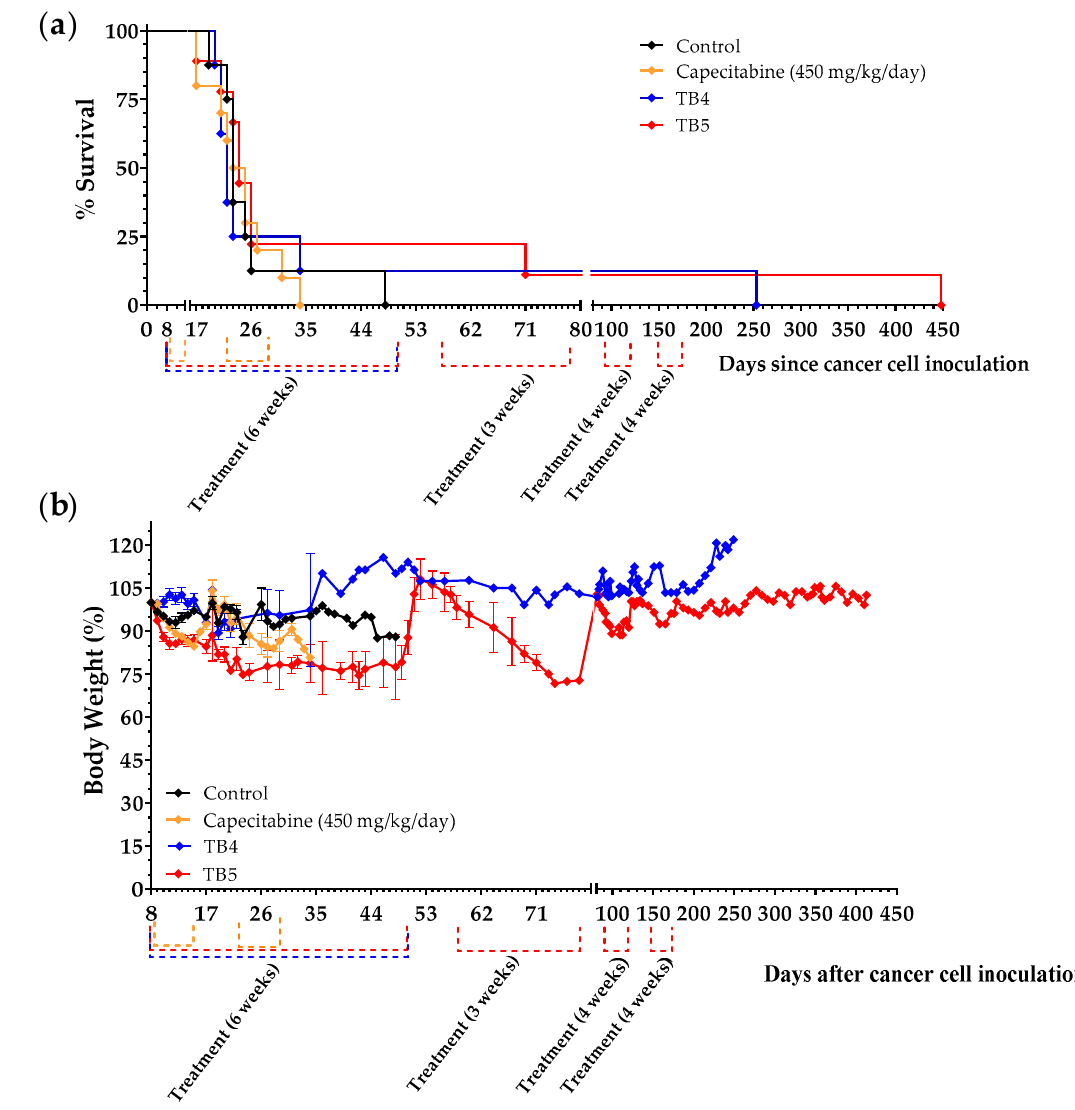
Figure 9. Anticancer activity of diets TB4 and TB5 and capecitabine in mice with metastatic TNBC cancer (4T1 murine breast cancer cells inoculated in the tail vein of immunocompetent BALB/c mice). ( a ) Survival of mice left untreated (control), treated with diet TB4 (6 weeks), treated with diet TB5 (6 weeks) or treated with capecitabine (450 mg/kg/day, 7/7 schedule, 3 cycles). ( b ) Body weights (mean percentage ± SEM) relative to the body weights of mice at the beginning of treatments (day 8). The two mice fed diet TB5 that lived longer are from the same experiment.